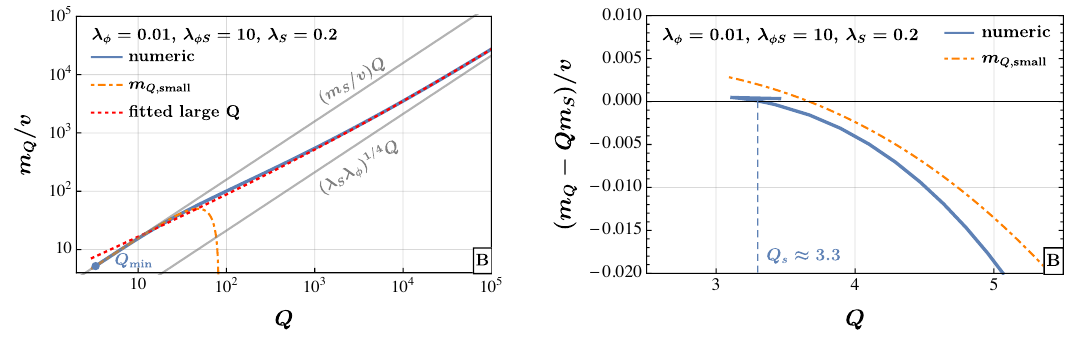
Figure 1 . Left panel: The Q-ball mass as a function of charge Q in Model B. The upper gray line shows the total mass of Q free S particles. The lower gray line shows the leading Q dependence of the Q-ball mass in the large- Q limit. The numerically obtained Q-ball mass spectrum is fitted with a linear term of Q plus a Q 2 / 3 term as in (2.7), and the fit result is given as the red dotted line. The fitted coefficient for the Q term matches well with ( λ S λ φ ) 1 / 4 . Right panel: The zoom-in region for small Q , showing the mass difference of the Q-ball and Q free S particles as a function of Q . A negative value means that the Q-ball is stable against decaying into Q free S